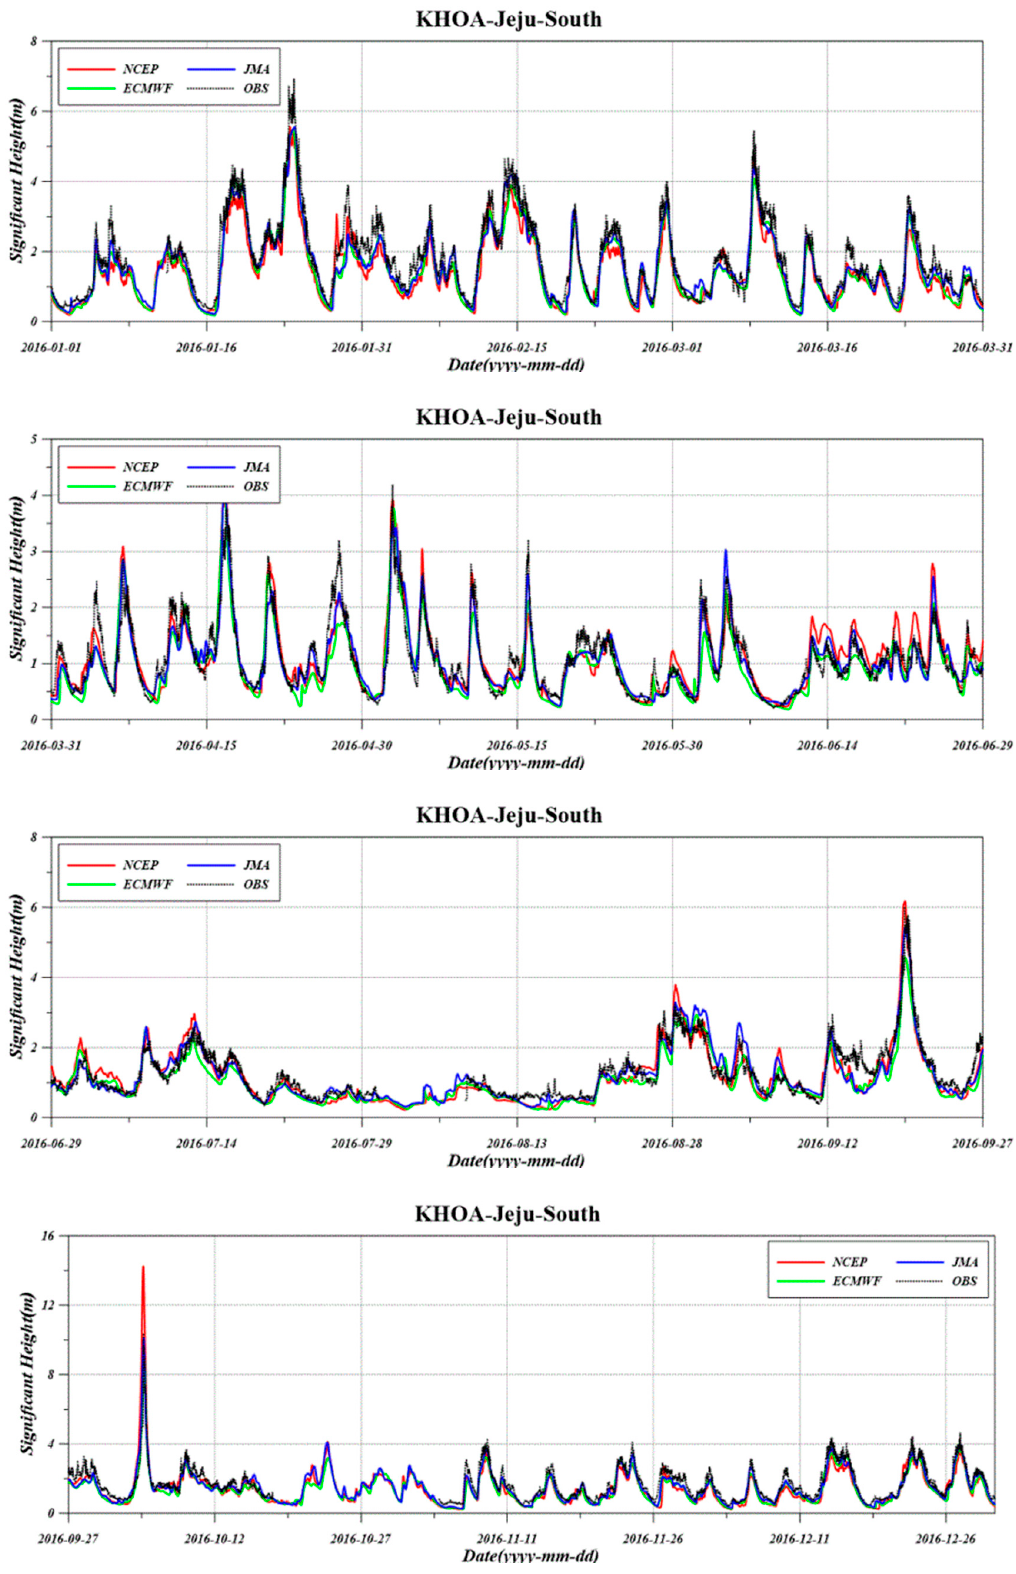
Figure 4. Measured and computed time series of significant wave heights at Korea Hydrographic and Oceanographic Agency (KHOA)-Jeju-South station in 2016.